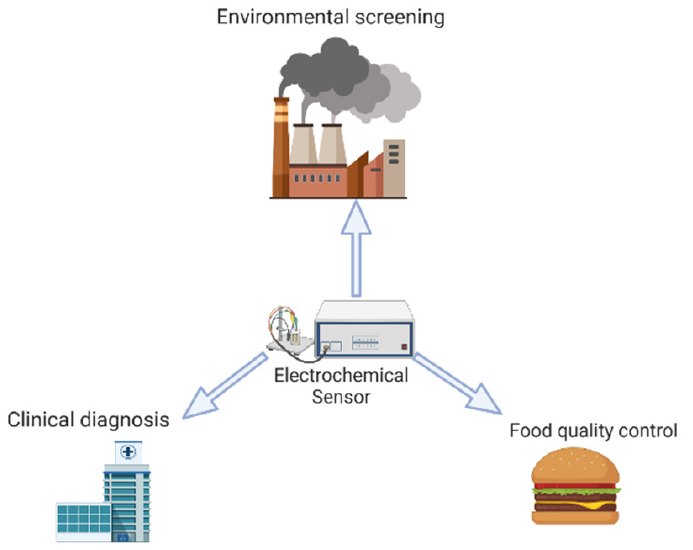
Figure 5. Schematic depiction of the application of electrochemical sensors.